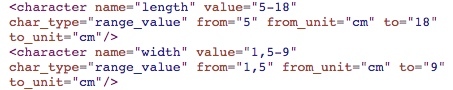
Result of structuring the chunk "5-18 x 1.5-9 cm".